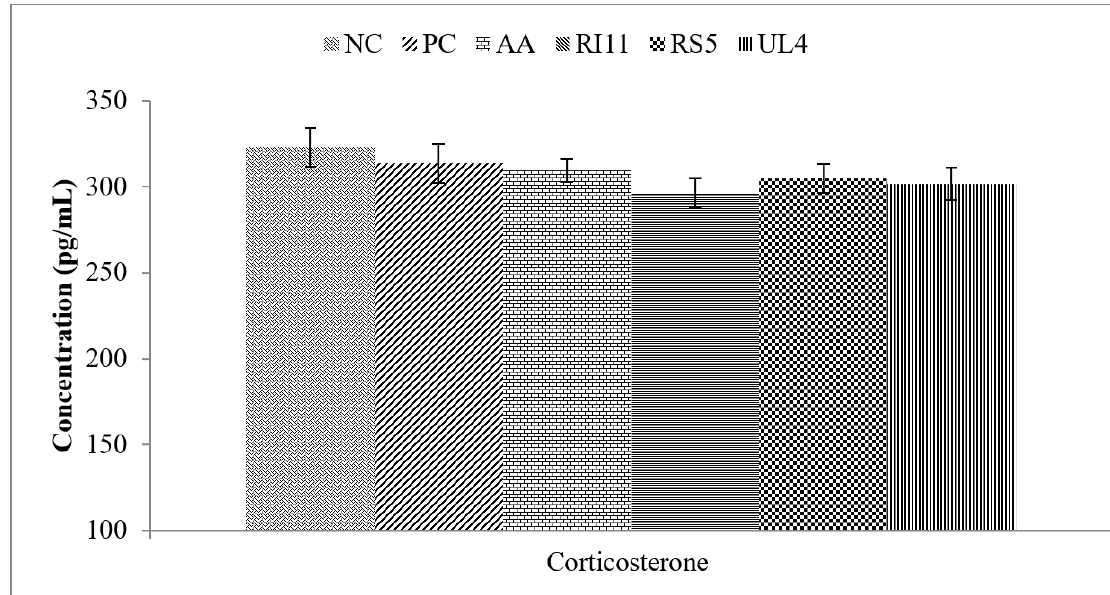
Figure 2. E ff ect of feeding di ff erent postbiotics on plasma corticosterone concentration in heat-stressed broiler chickens. Data represent means and standard error ( n = 12). Diets: Negative control (NC): basal diet without any supplementation, Positive control (PC): basal diet + 0.02% oxytetracycline ( w / w ), AA: basal diet + 0.02% ascorbic acid ( w / w ), RI11: basal diet + 0.3% postbiotic RI11 ( v / w ), RS5: basal diet + 0.3% postbiotic RS5 ( v / w ), UL4: basal diet + 0.3% postbiotic UL4 ( v / w ).